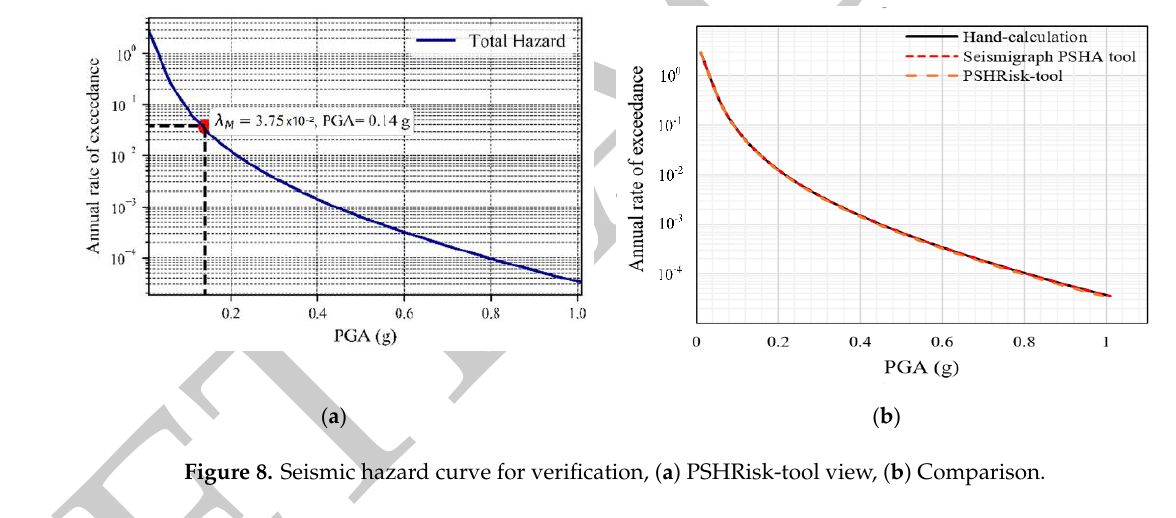
Figure 8. Seismic hazard curve for verification, ( a ) PSHRisk-tool view, ( b ) Comparison.